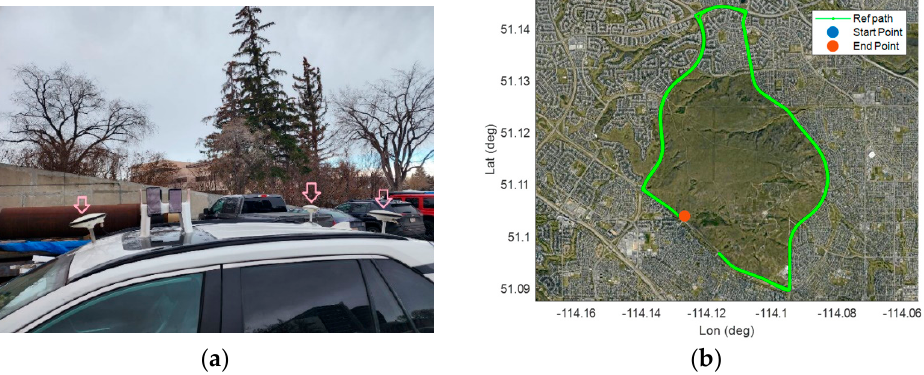
Figure 11. Kinematic experiment done on 22 April 2022 ( a ): test configuration and ( b ): Reference